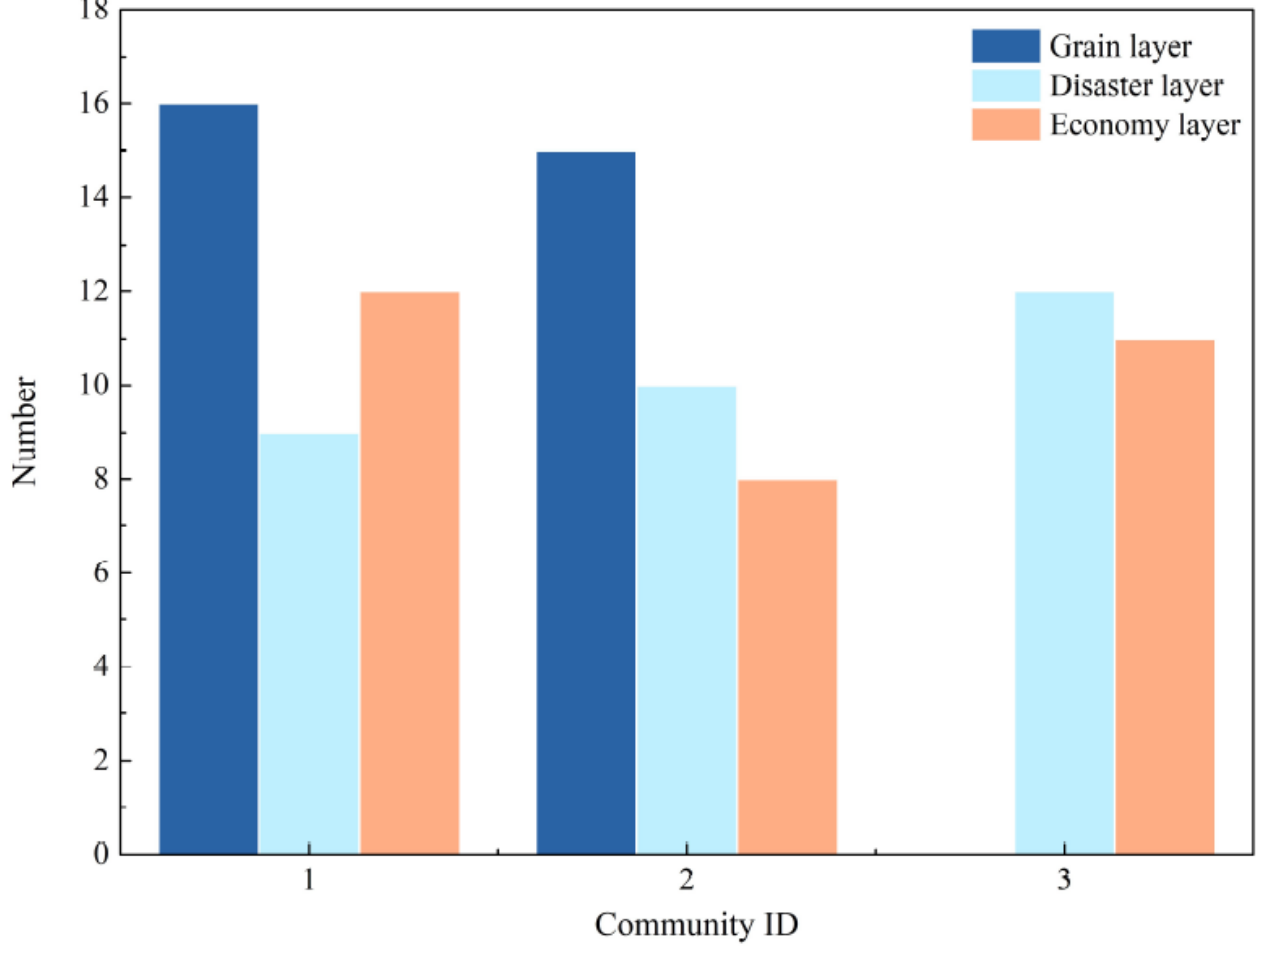
Figure 10. Community number of the grain–disaster–economy multilayer network.